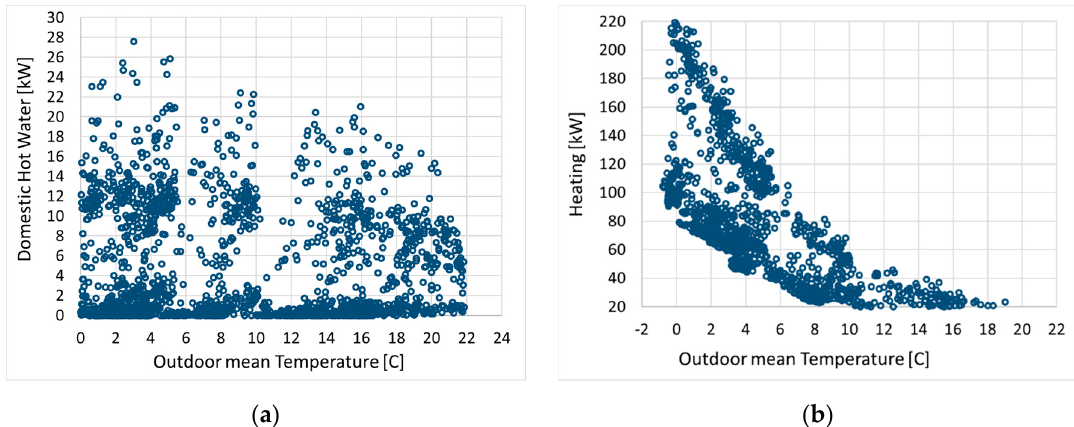
Figure 12. Electric consumption in function of outdoor mean temperature, daily data: ( a ) DHW; ( b ) air heating.